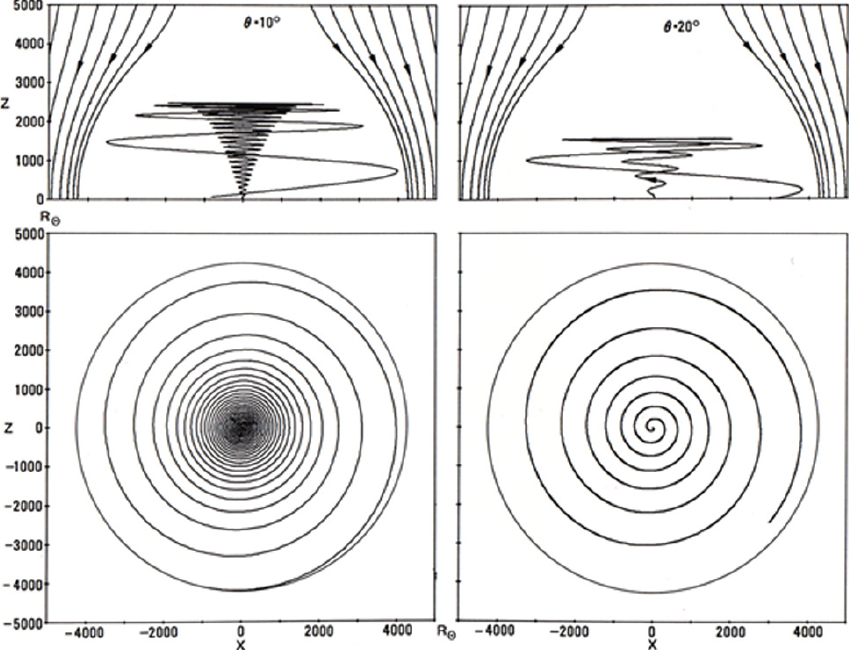
Fig. 27b. The interplanetary magnetic field lines, originating at polar angles of 10 ◦ and 20 ◦ , in the heliosphere, computed on the basis of Fig. 24a (Akasofu and Covey,